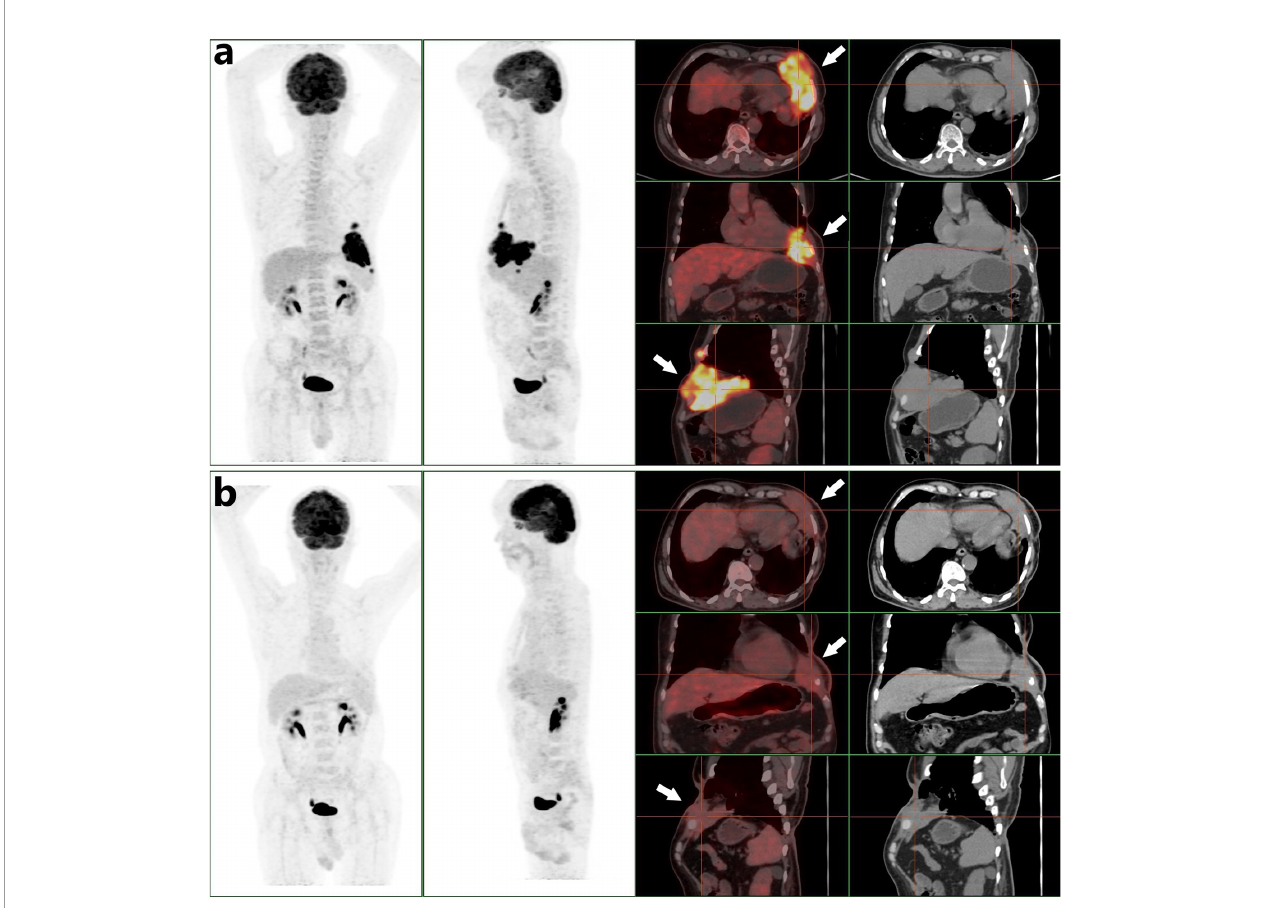
FIGURE 2 | (A) A PET/CT scan obtained before combined oncotherapy on April 9 2019 (white arrows, the tumor mass with high FDG metabolism). (B) A PET/CT scan obtained before surgery on September 30 2019 (white arrows, the tumor mass was smaller than before and its FDG metabolism was less than